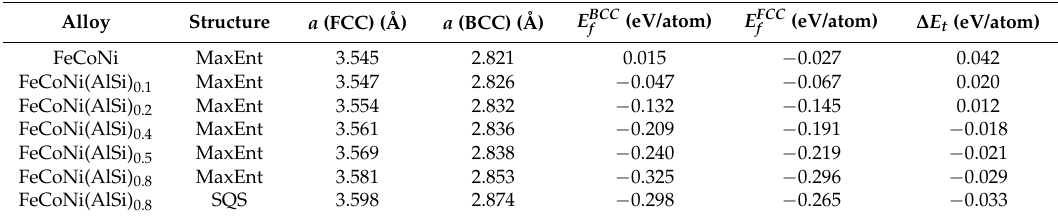
Figure 1. Crystal structures of the MaxEnt structures and special quasi-random structures (SQS) structure in their ideal, unrelaxed forms: ( a ) MaxEnt-108 for x = 0.2; ( b ) MaxEnt-128 for x = 0.4; ( c ) MaxEnt-128 for x = 0.8; ( d ) SQS-92 for x = 0.8. Table 1. Calculated lattice parameters ( a ), formation enthalpies and the energy differences between face-centered cubic (FCC) phase and body-centered cubic (BCC) phases as a function of Al and Si fraction